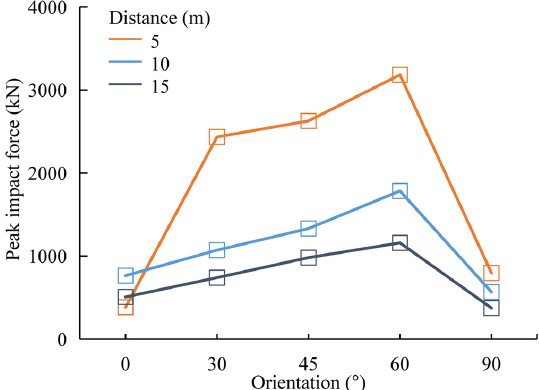
Figure 18. Peak impact forces change with the target building’s ori- entations under the shielding effect. The orange line shows the case of Orx-Op0.4- A 0- D 5, the blue line shows the case of Orx-Op0.4- A 0- D 10 and the gray line shows the case of Orx-Op0.4- A 0- D